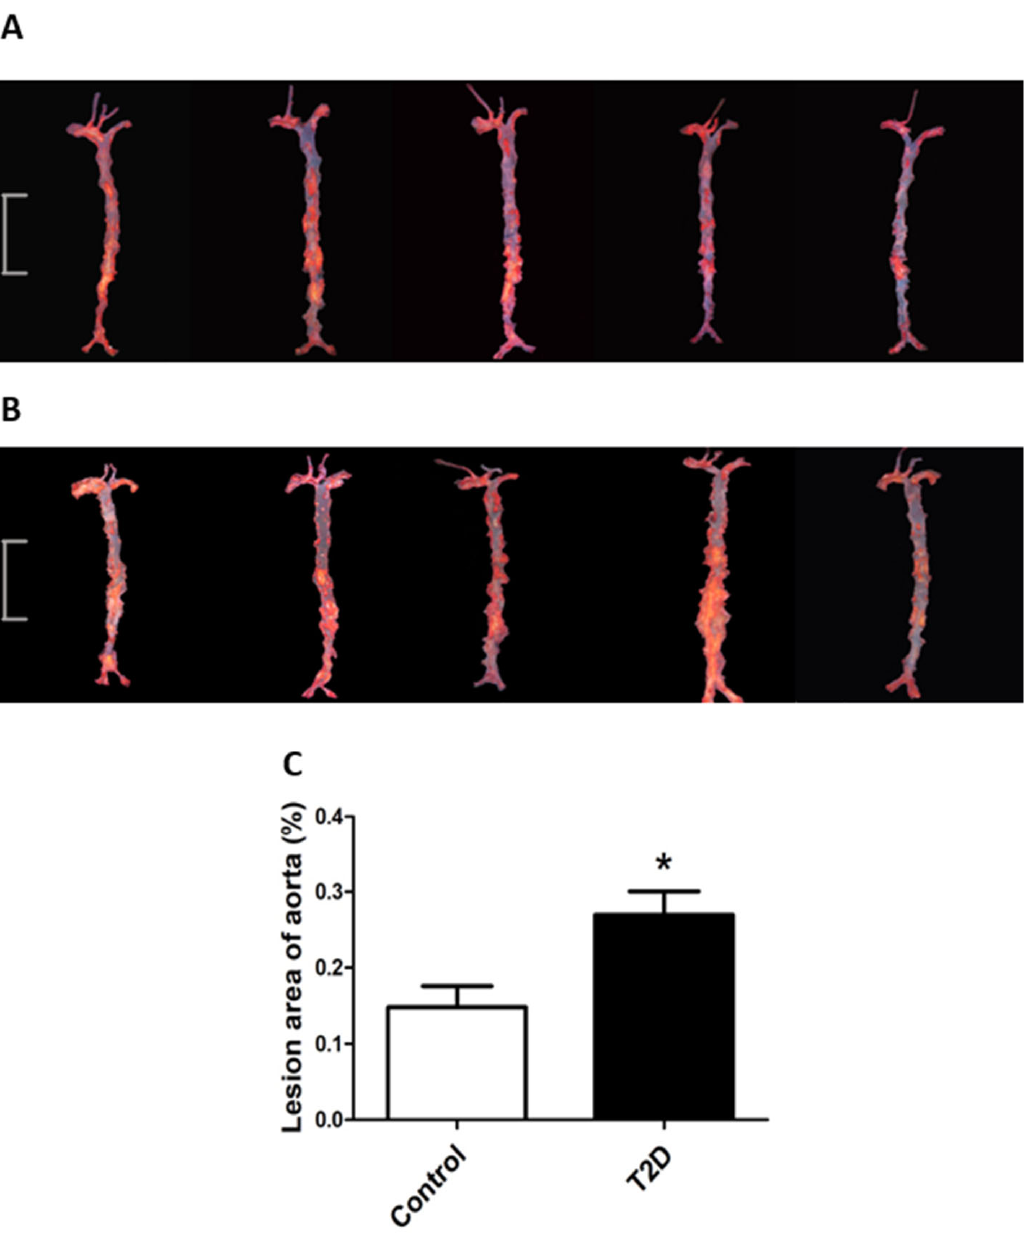
Figure 3. The progression of atherosclerotic plaques in the aorta was accelerated in streptozocin (STZ)-induced type 2 diabetic ApoE-/- mice. The aortas of the control ( A ) and T2D ( B ) mice were dissected and stained with oil red O. Scale bar is 1cm ( A , B ). ( C ) The atherosclerotic lesions in the aorta were quantified using methods described in the Materials and Methods section. Data were statistically analyzed using the independent sample t-test in the SPSS 20.0 software. Results represent means ± S.D. of the samples from five ( n = 5) mice in each group. *: p < 0.05 vs. control.